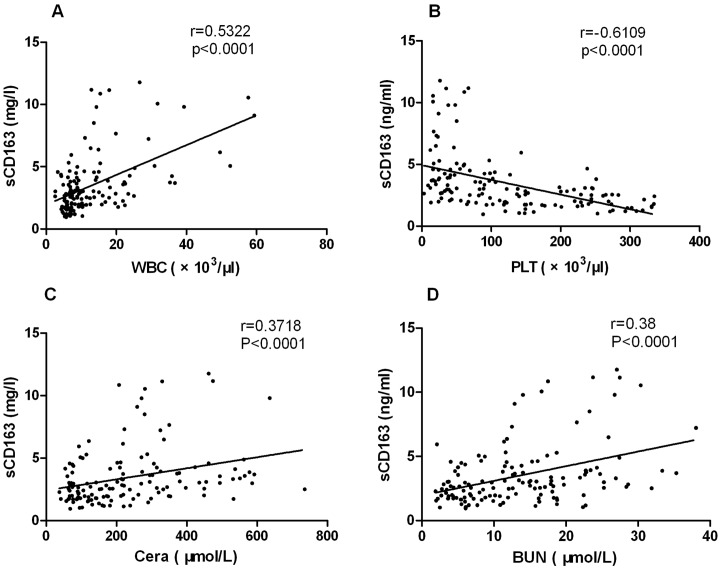
The relationship between elevated sCD163 plasma levels and the clinical parameters.The values are derived from the same blood sample from the HFRS subjects during hospitalization. The Spearman correlation test was used to test the correlation between the sCD163 levels and clinical parameters. The serum sCD163 concentrations were positively correlated with the white blood cells (WBC) (A), creatinine (Crea) (C), and the blood urea nitrogen (BUN) (D) levels for the entire group of subjects while they were negatively correlated with the platelet count (PLT) (B) levels. The r and P values are indicated in the graphs.